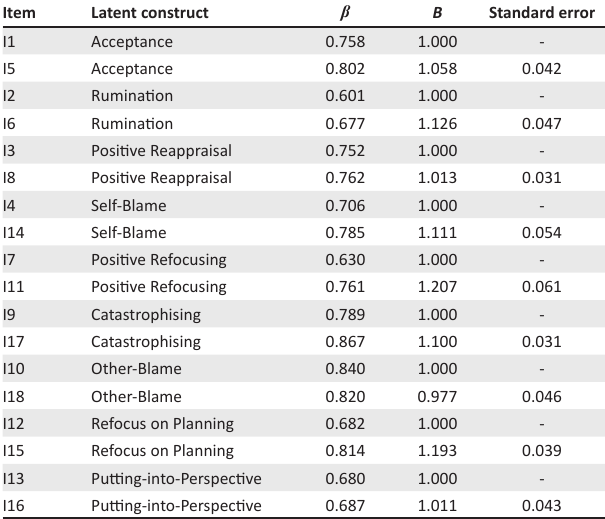
TABLE 4: Standardised and unstandardised coefficients for the items of the Cognitive Emotion Regulation Questionnaire-short. Item